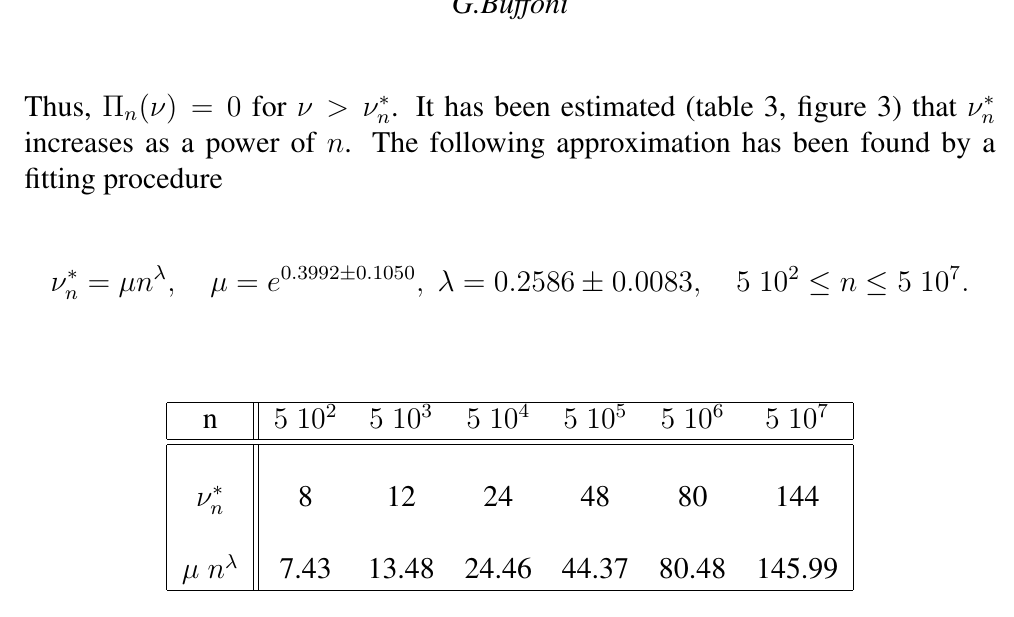
Table 3: Computed values of ν ∗ of n